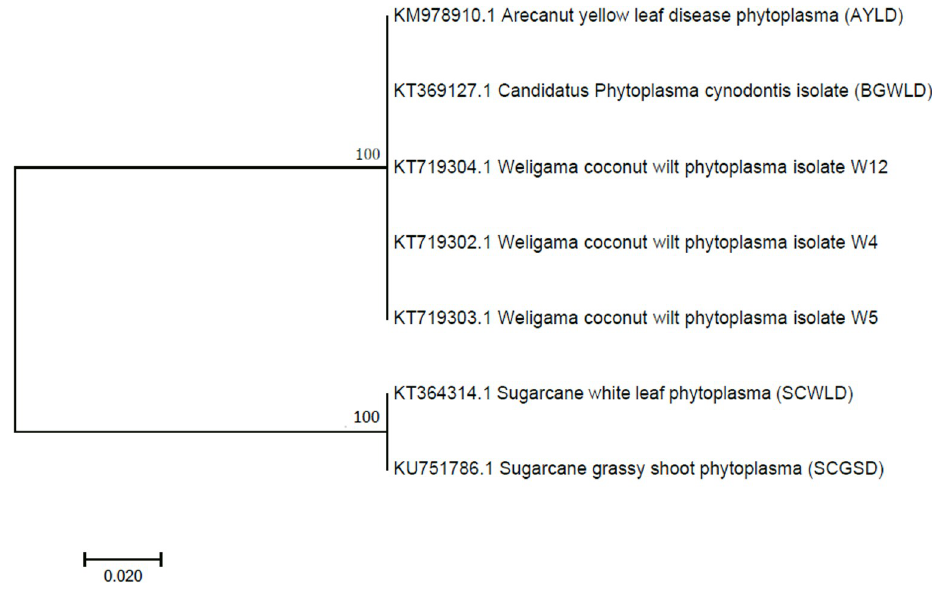
Fig 4. Maximum likelihood phylogram based on partial secA sequences of WCLWD, AYLD, SCWLD, SCGSD and BGWLD associated phytoplasma strains. A bootstrap test of 1,000 replication was performed to examine the reliability of the phylogeny. Numbers at nodes indicate percentage bootstrap support probability values. The GenBank accession number is preceded by the phytoplasma name.